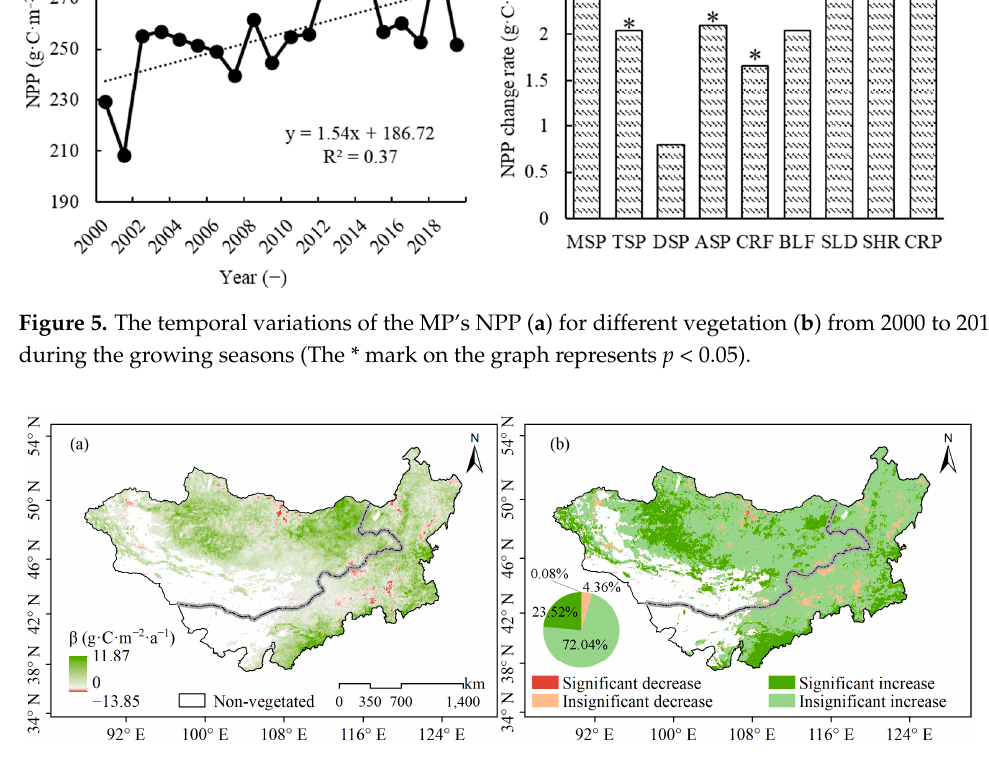
Figure 6. The spatial distribution of NPP’s changing trend during the growing seasons from 2000 to 2019 in the MP (( a ) NPP’s spatial change rate; ( b ) the classi fi cation of the signi fi cance of the changing trend).